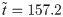
Test 2: POD-Galerkin ROM solutions for different testing-parameter instances.POD-Galerkin ROM solution (left) and relative error ϵk (right) for Nc = 2 (top) and Nc = 4 (bottom) at t˜=157.2 ms, for μtest = 0.9625 cm.